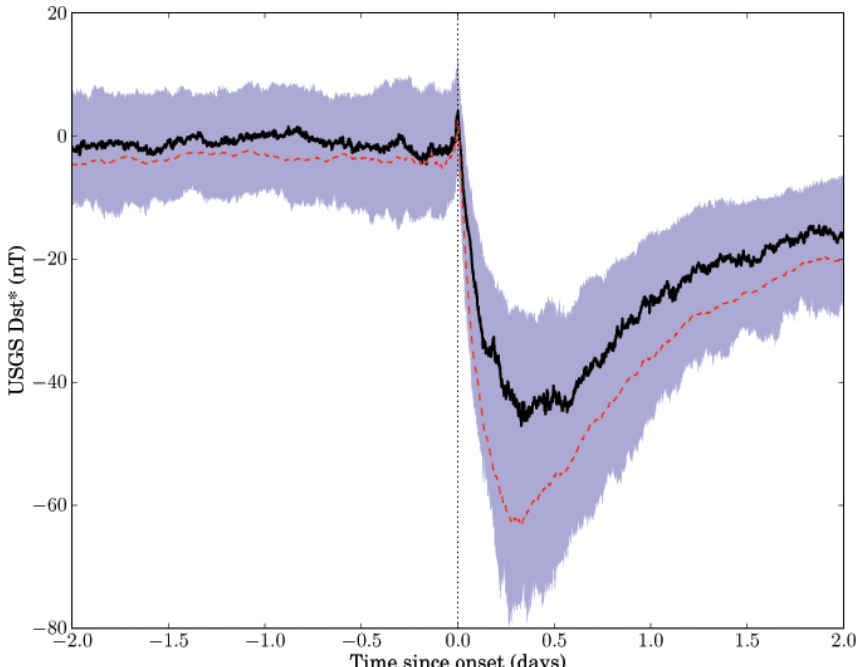
Fig. 1. Superposed epoch plot of Dst ∗ as a function of time since storm onsets identified as described in the text. Plotted here are the superposed epoch median (black line), mean (dashed red line), and interquartile range (blue shaded